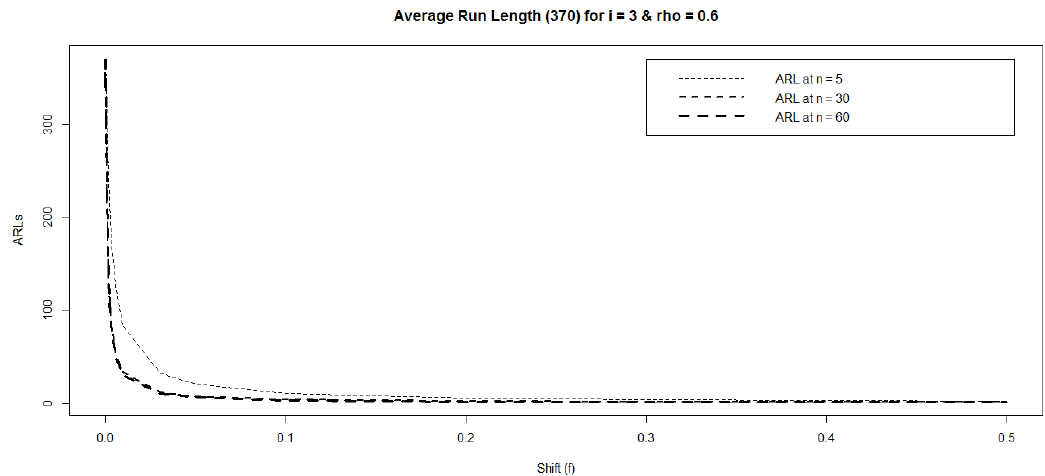
Figure 2. Trend of ARLs according to shift constant when ARL 0 = 370, i = 3 and ρ = 0.6 with n = 5, 30, 60 .